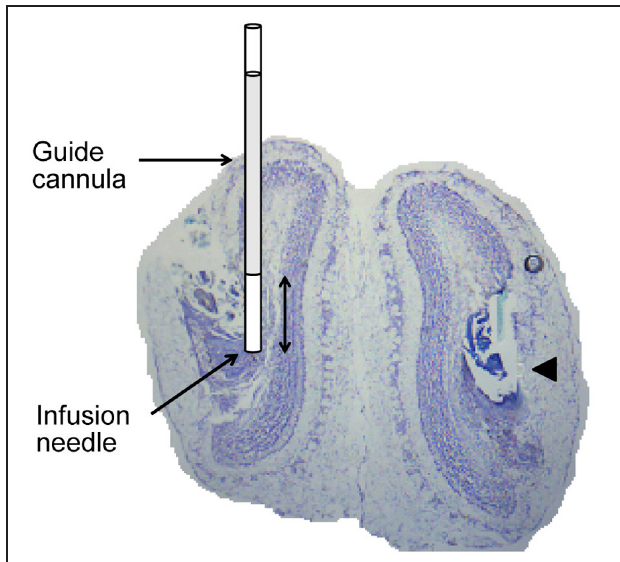
FIGURE 2 | Histological verification of cannula placement. Coronal section through the OB illustrating placement of guide cannula and infusion needle. The arrowhead points to a cannula track in the right OB. Double headed arrow is 1mm.